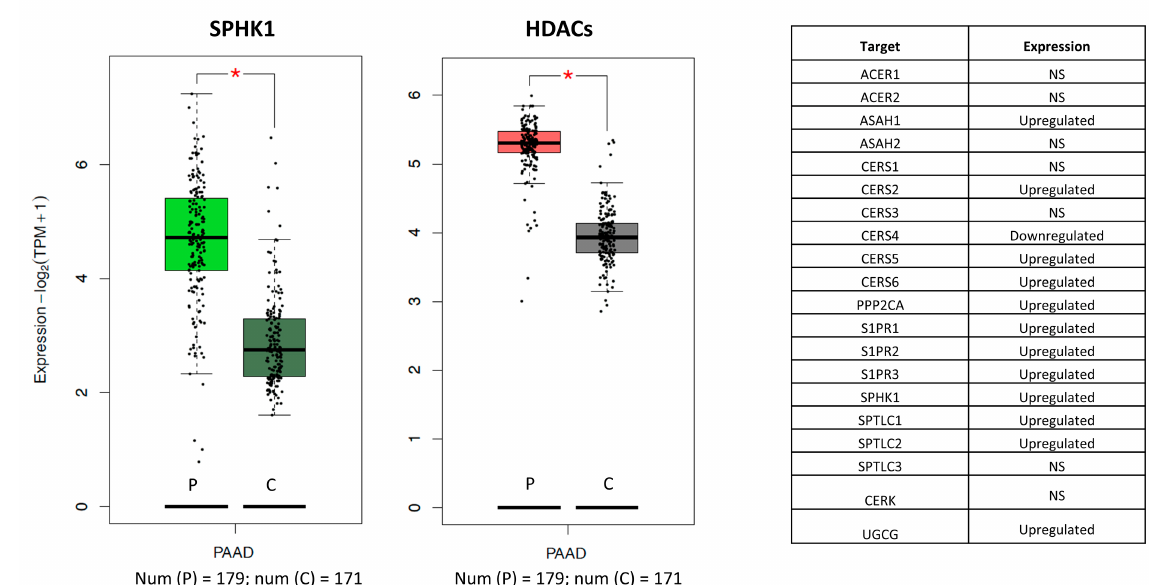
Figure 2. SPHK1 and HDACs (class I) are upregulated in pancreatic cancer. Left—Box plot of the expression for the central regulator of sphingolipid rheostat; Middle—Box plot of the expression of class I HDACs; Right—Table of summarized expressions for all component of sphingolipid signaling pathway identified in the study. P indicates patient tissue, C indicates healthy control, the asterisk (*) indicates significant change in the expression ( p -value cutoff 0.01) while NS indicates non-significant change in expression between patient and normal tissue.